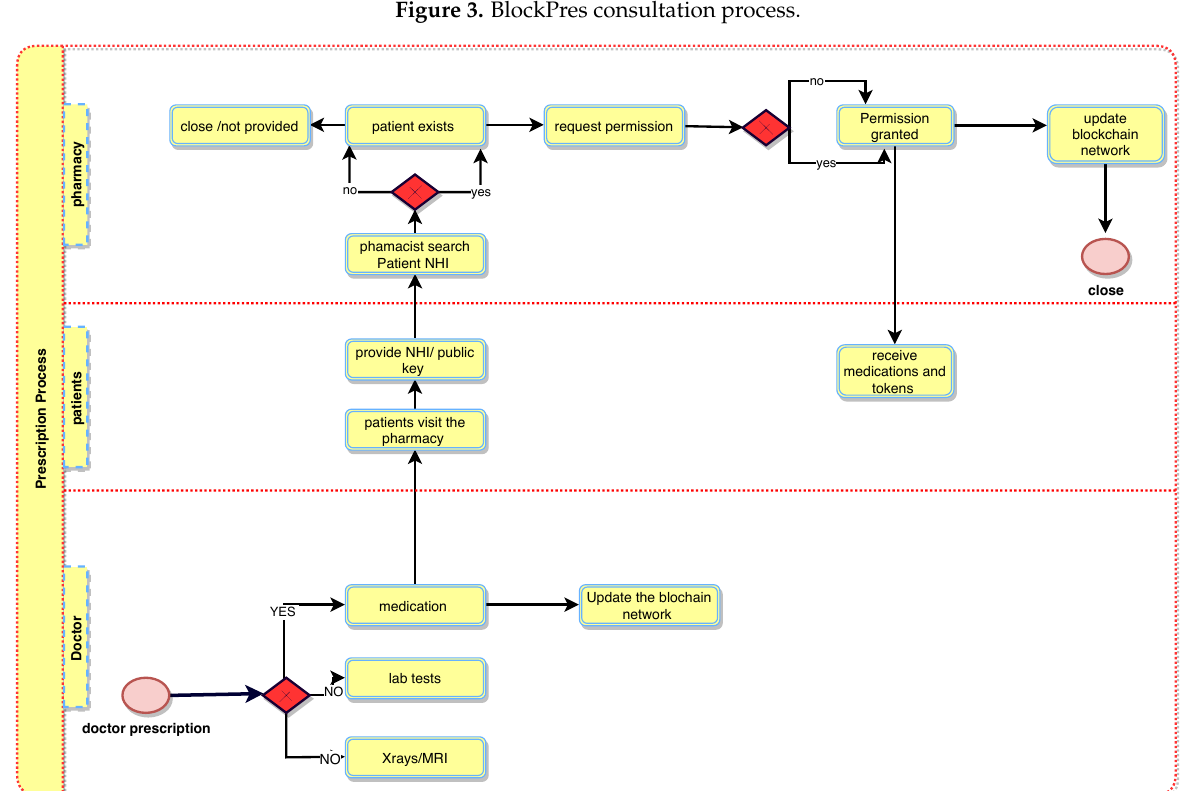
Figure 4. BlockPres prescription